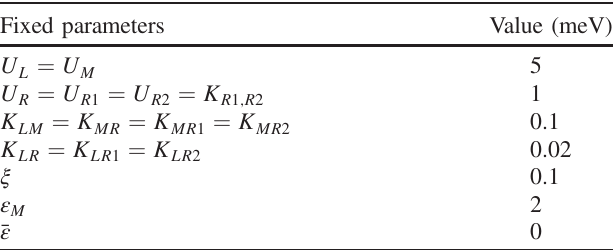
TABLE II. Summary of parameters used in the Hubbard model for all presented simulations. Fixed parameters